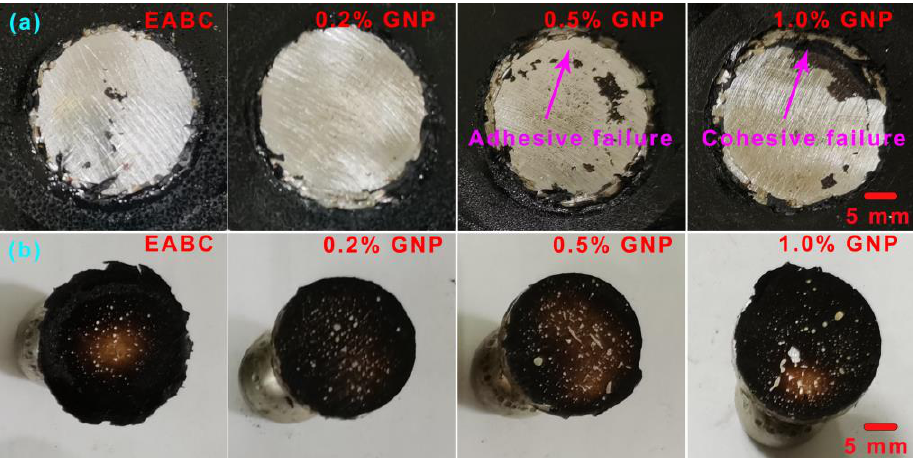
Figure 18. Surfaces of steel plates ( a ) and dollies ( b ) bonded by GNP-reinforced EABCs after pull-off adhesion tests at 60 °C.